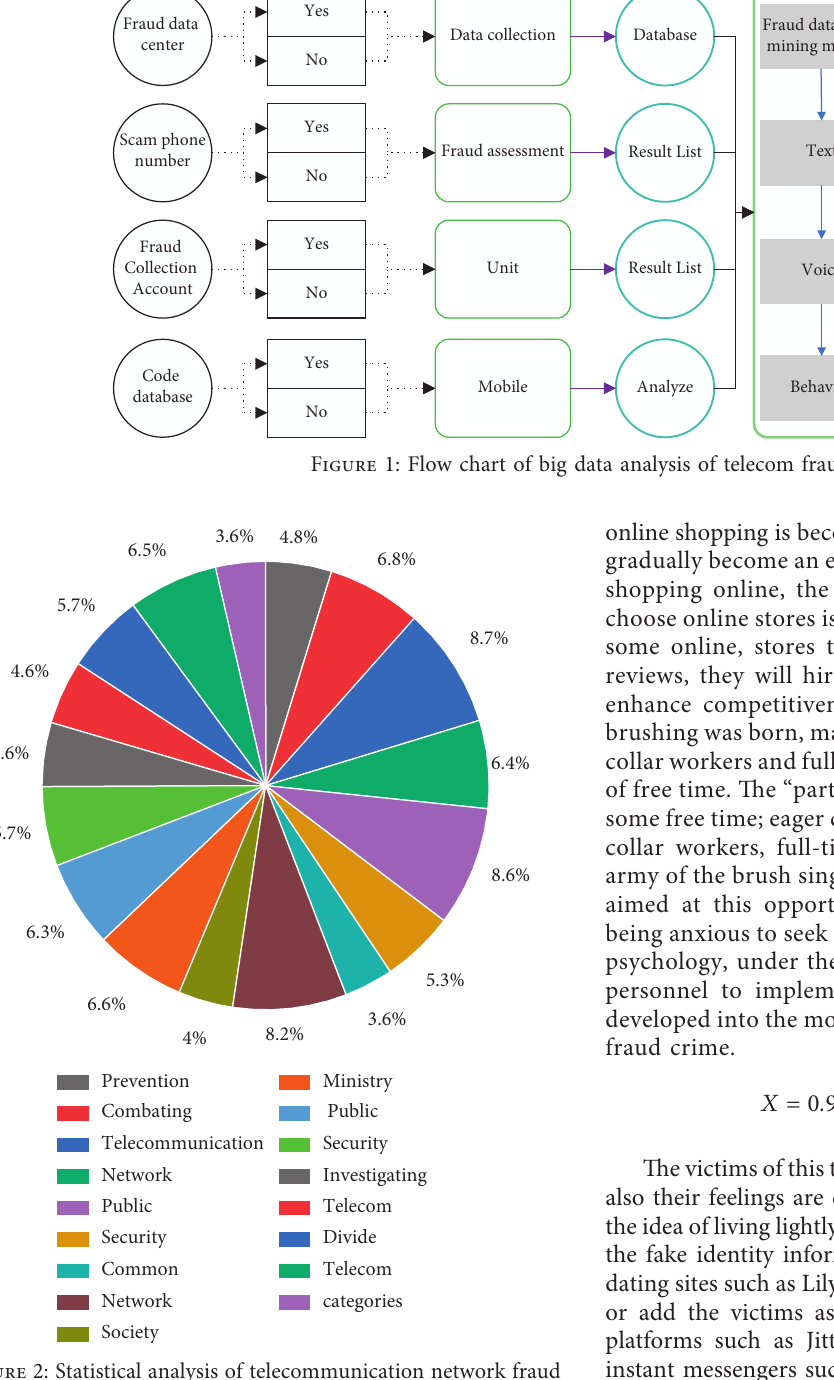
Figure 2: Statistical analysis of telecommunication network fraud